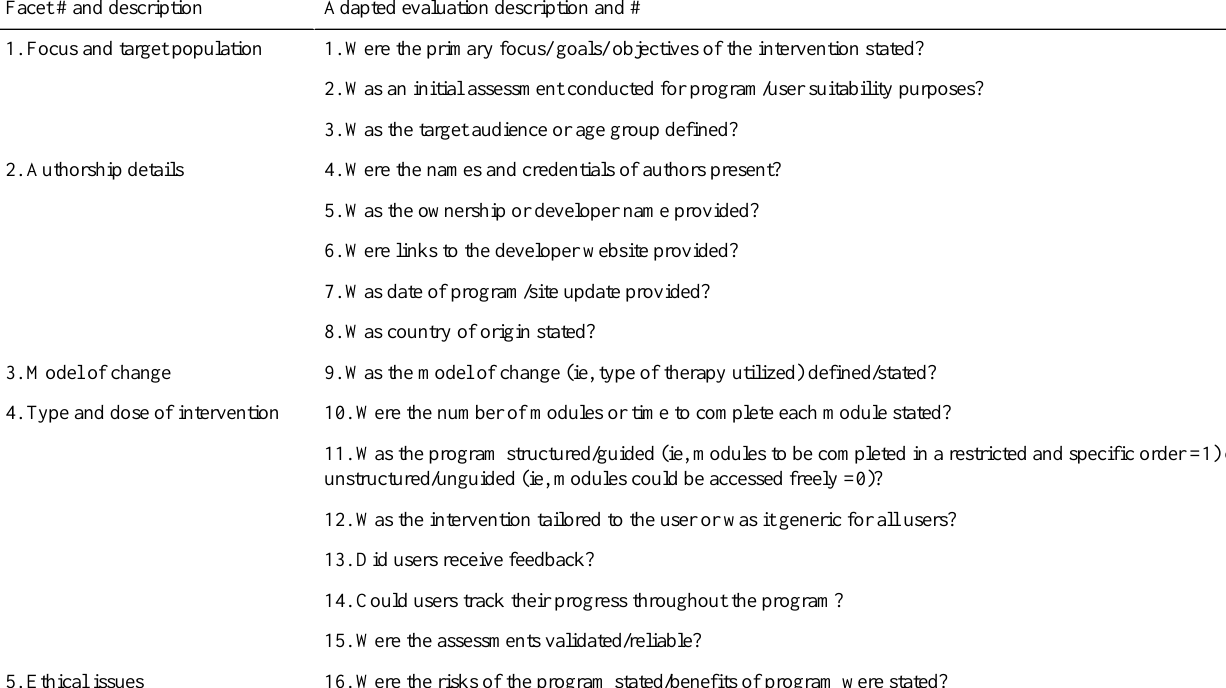
Adapted evaluation description and #Facet # and